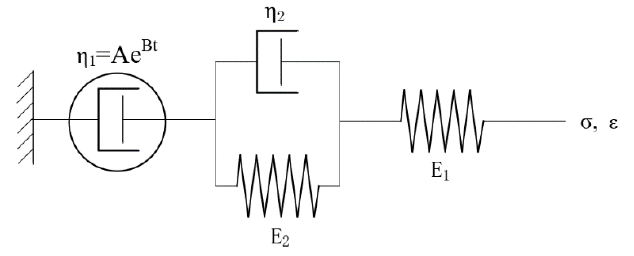
Figure 2. Burgers model with four units and five parameters.